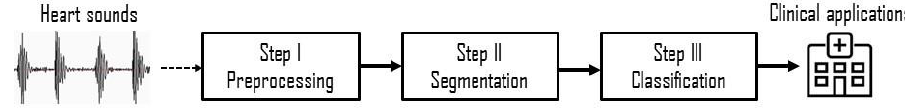
Figure 1. Generic pipeline for heart sounds classification [7].